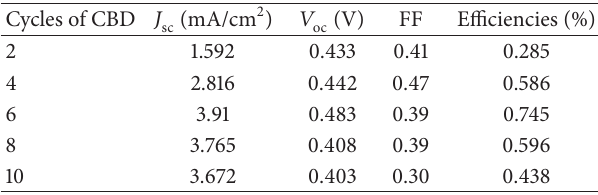
Table 1: The parameters of QDSSCs with CBD cycles of 2 ∼